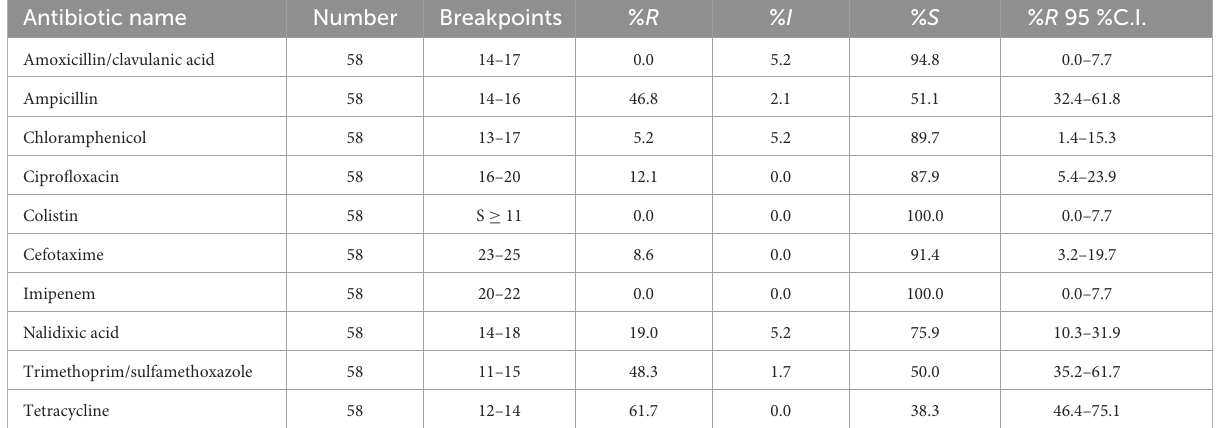
TABLE 5 Antibiotic resistance profiles for E. coli isolates. Antibiotic